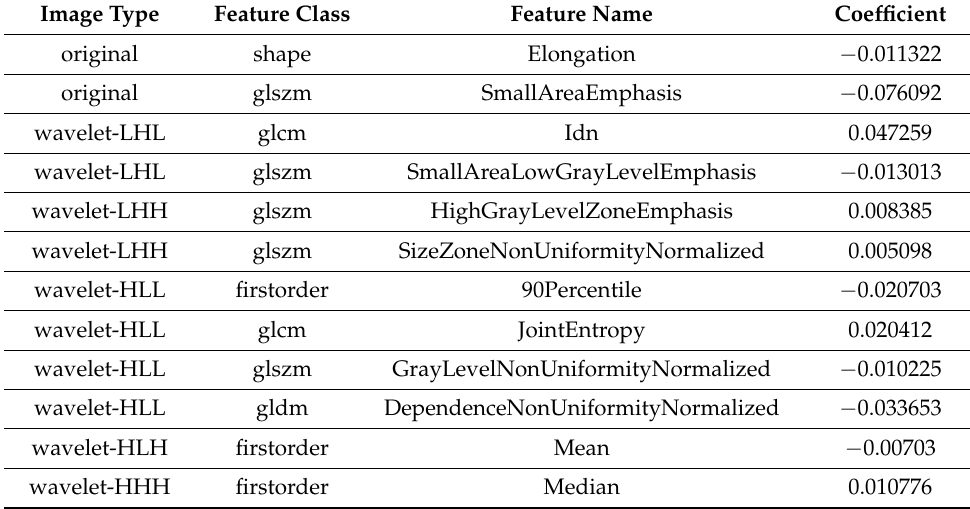
Table 2. List of features with nonzero coefficients.